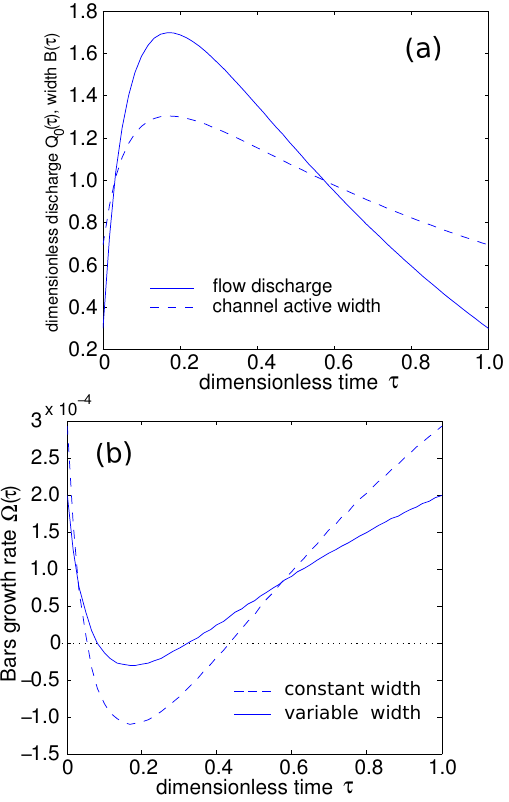
Fig. 3. The linear growth rate of alternate bars (real part of (cid:127) 11 ) is plotted vs. the Shields stress ¯ θ for different values of the roughness parameter ¯ d s for the case of variable width with (a) variable, (b) constant